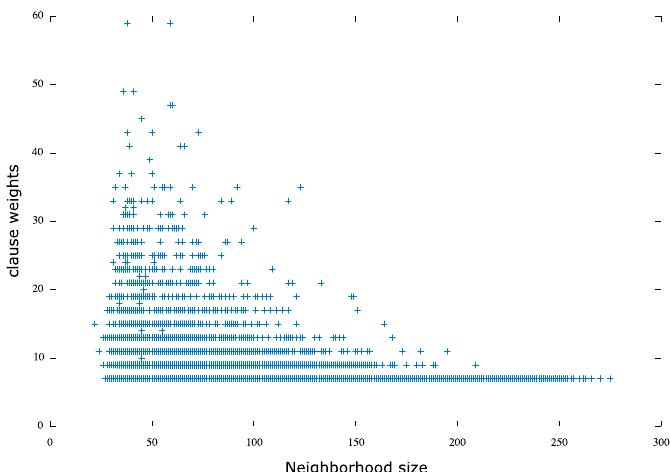
Figure 3. The figure illustrates the most weighted clauses and their corresponding neighborhood size for the jnh problem set (20 instances), where the overall average of the neighborhood size is ≈ 107. uuf problem set: Figure 4 illustrates an overview of the uniform unsatisfiable problem set weight distribution where 83% of the clauses were least weighted with the large neighborhood and 17% of the clauses were most weighted and had a small neighborhood